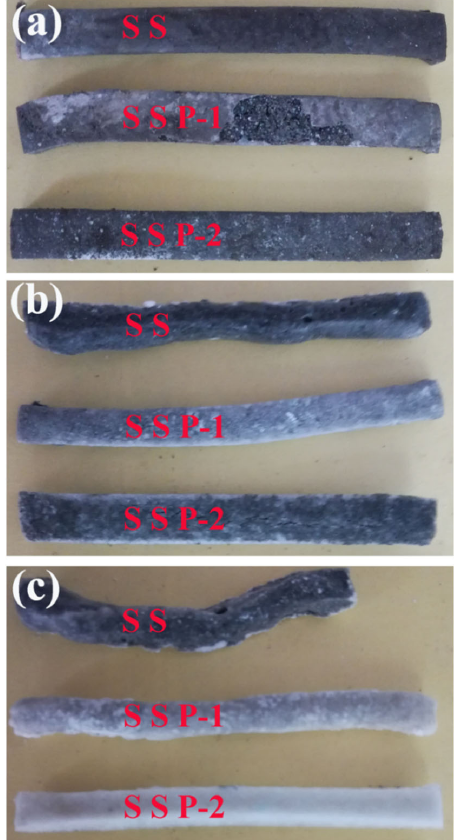
Figure 2. Surface morphology of all samples fired at 700 °C ( a ), 850 °C ( b ), and 1000 °C ( c ).